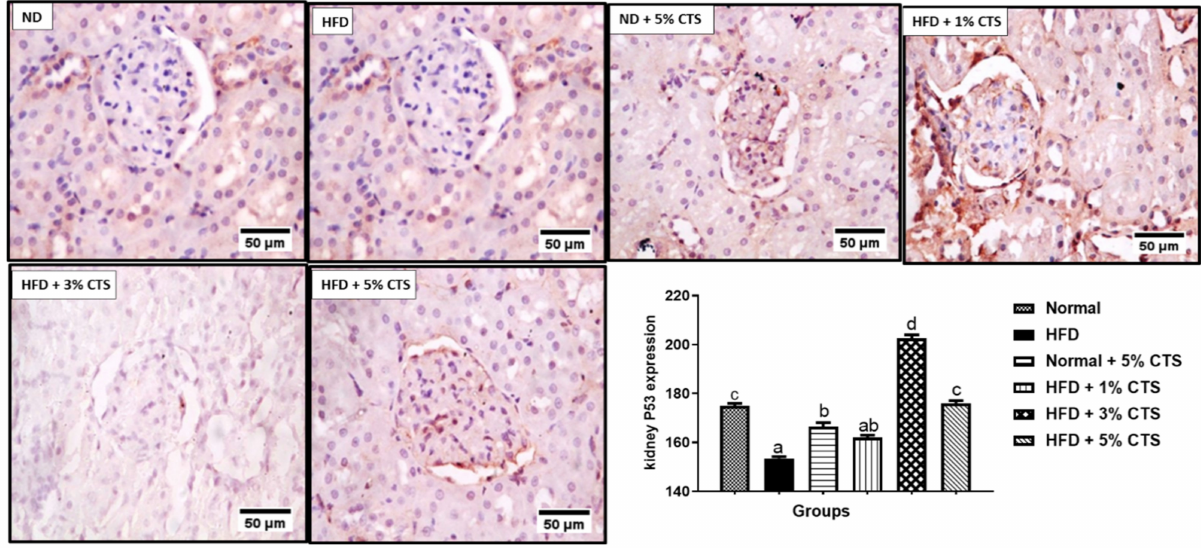
Figure 6. Photomicrograph of immune-histochemical expression of renal p53. Values are expressed as mean ± SEM ( n = 3). Bars with distinct letters are statistically ( p < 0.05) different. ND- normal diet; HFD- high-fat diet; CTS-